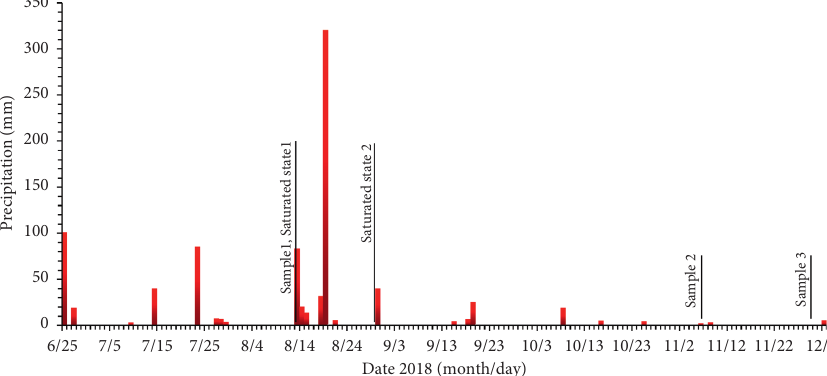
Figure 7: Daily rainfalls in the local saline-alkali soil